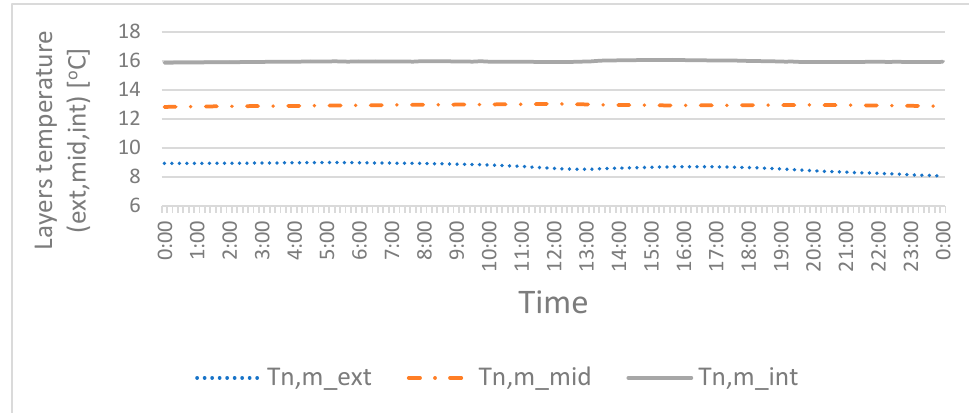
10 of 18 Figure 11. Graph of the average temperature in three layers of the wall on 22 June 2021. The temperature of the outer layer rises during the hours of solar operation on the wall and as the temperature of the outside air increases. Due to the solar gains through the windows, the room temperature also rises, which in turn heats the inner layer of the